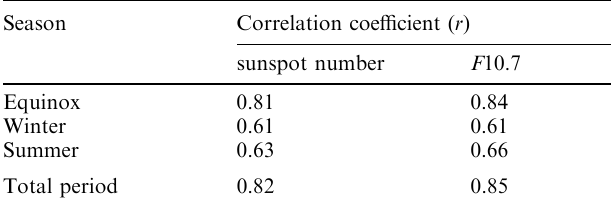
Table 1. The correlation coe(cid:129)cients of occurrence of night-time scintillations with sunspot number and F 10.7 for the three